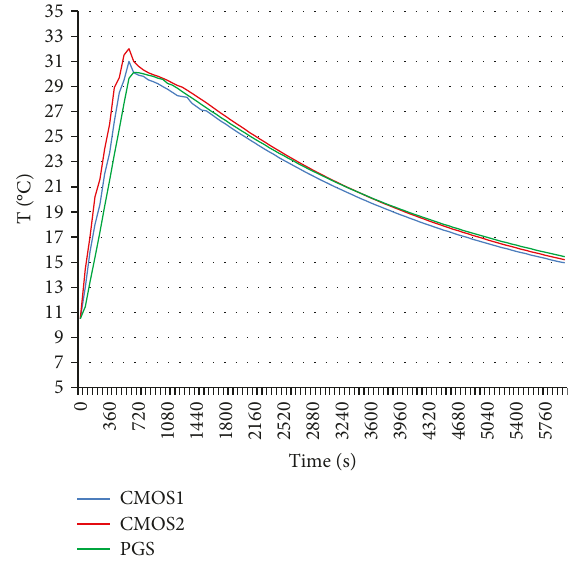
Figure 15: Thermal test temperature